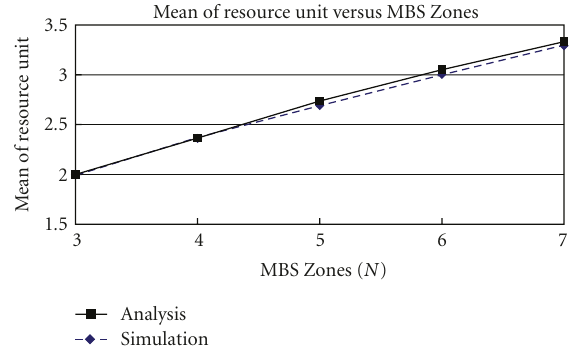
Figure 12: Average number of the required radio resource units in di ff erent MBS Zones.